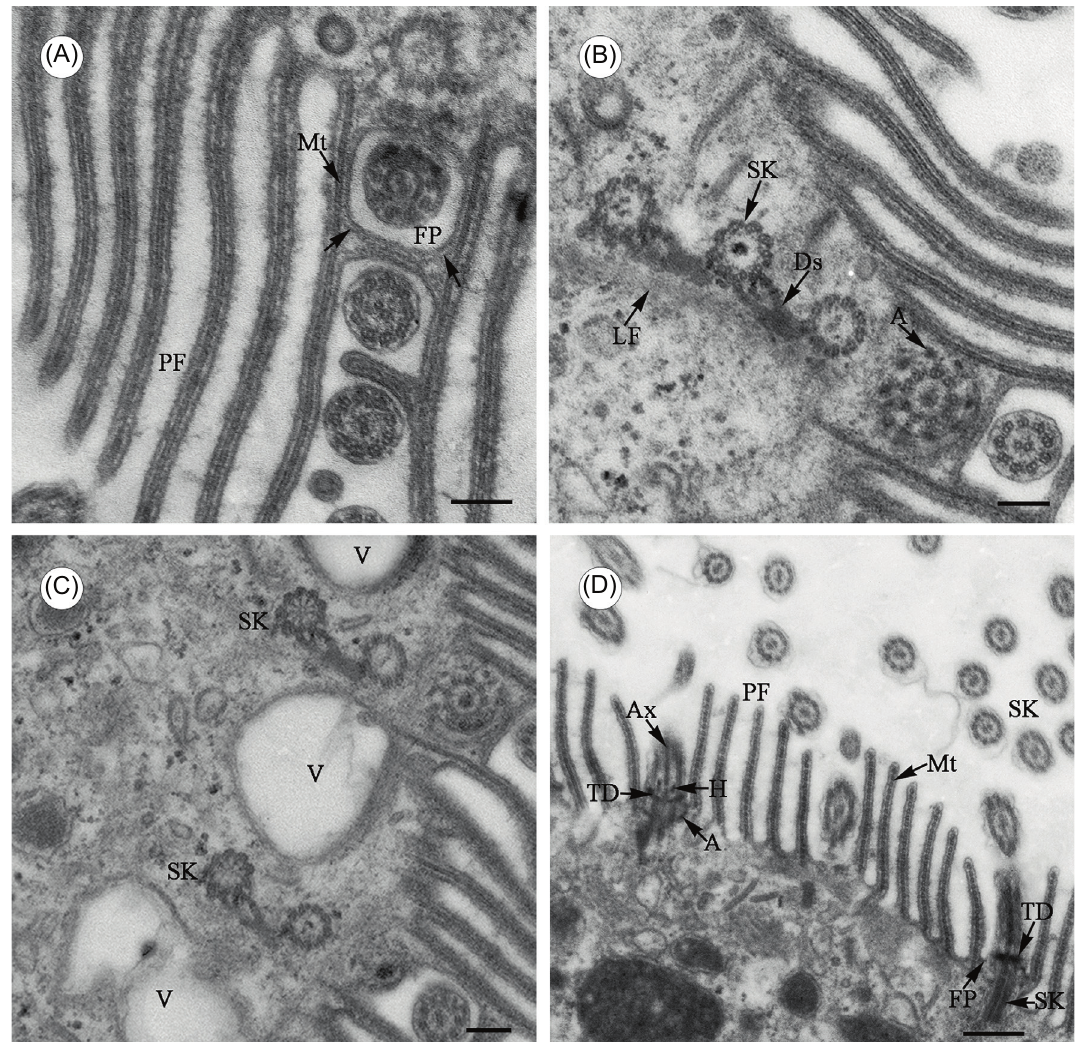
Figure 3. Transmission electron microscope images of Cepedea longa , to show fine structures of the somatic flagella. (A) Tangential section of a somatic kinety, to show fibrillar elements (arrow) between cortical microtubules (Mt) and around the membrane of each flagellar pit (FP). PF = pellicular folds. Scale bar = 2.5 l m. (B)–(C) Cross section through several kineties, to show somatic kinetosomes (SK) linked by desmoses (Ds) and sometimes interposed by vacuoles (V) just beneath the cell surface. A = kinetosomal arms. Scale bar = 2.5 l m. (D) Longitudinal section of kinetosomes, to show detailed fine structures. The axosome (Ax) is embedded in the proximal margin of transitional discs (TD), with curving arms (A) extending out and up. H = transitional helix, Mt = microtubules, SK = somatic kineties, PF = pellicular folds, FP = flagellar pit. Scale bar = 5 l